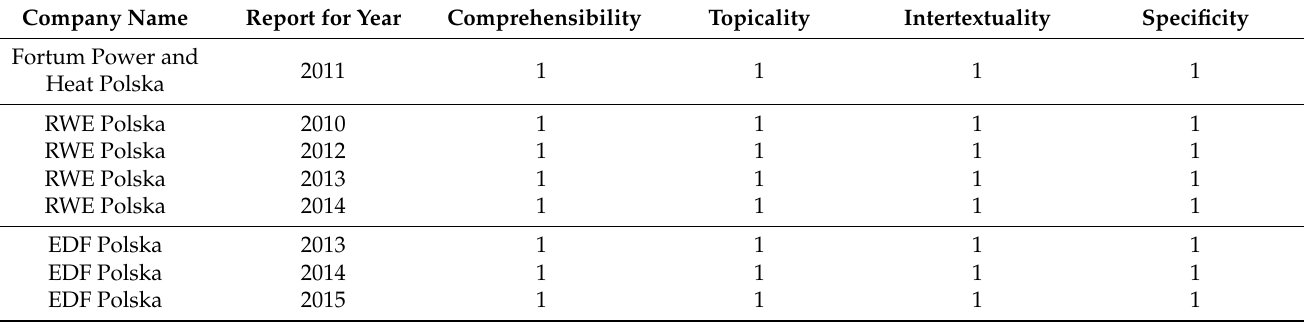
Figure 3. Author’s recommendations for energy companies listed on the Polish stock exchange in the area of reporting RMS information. Source: the authors. Table 10. Assessment of CGPs information included in energy companies’ non-financial